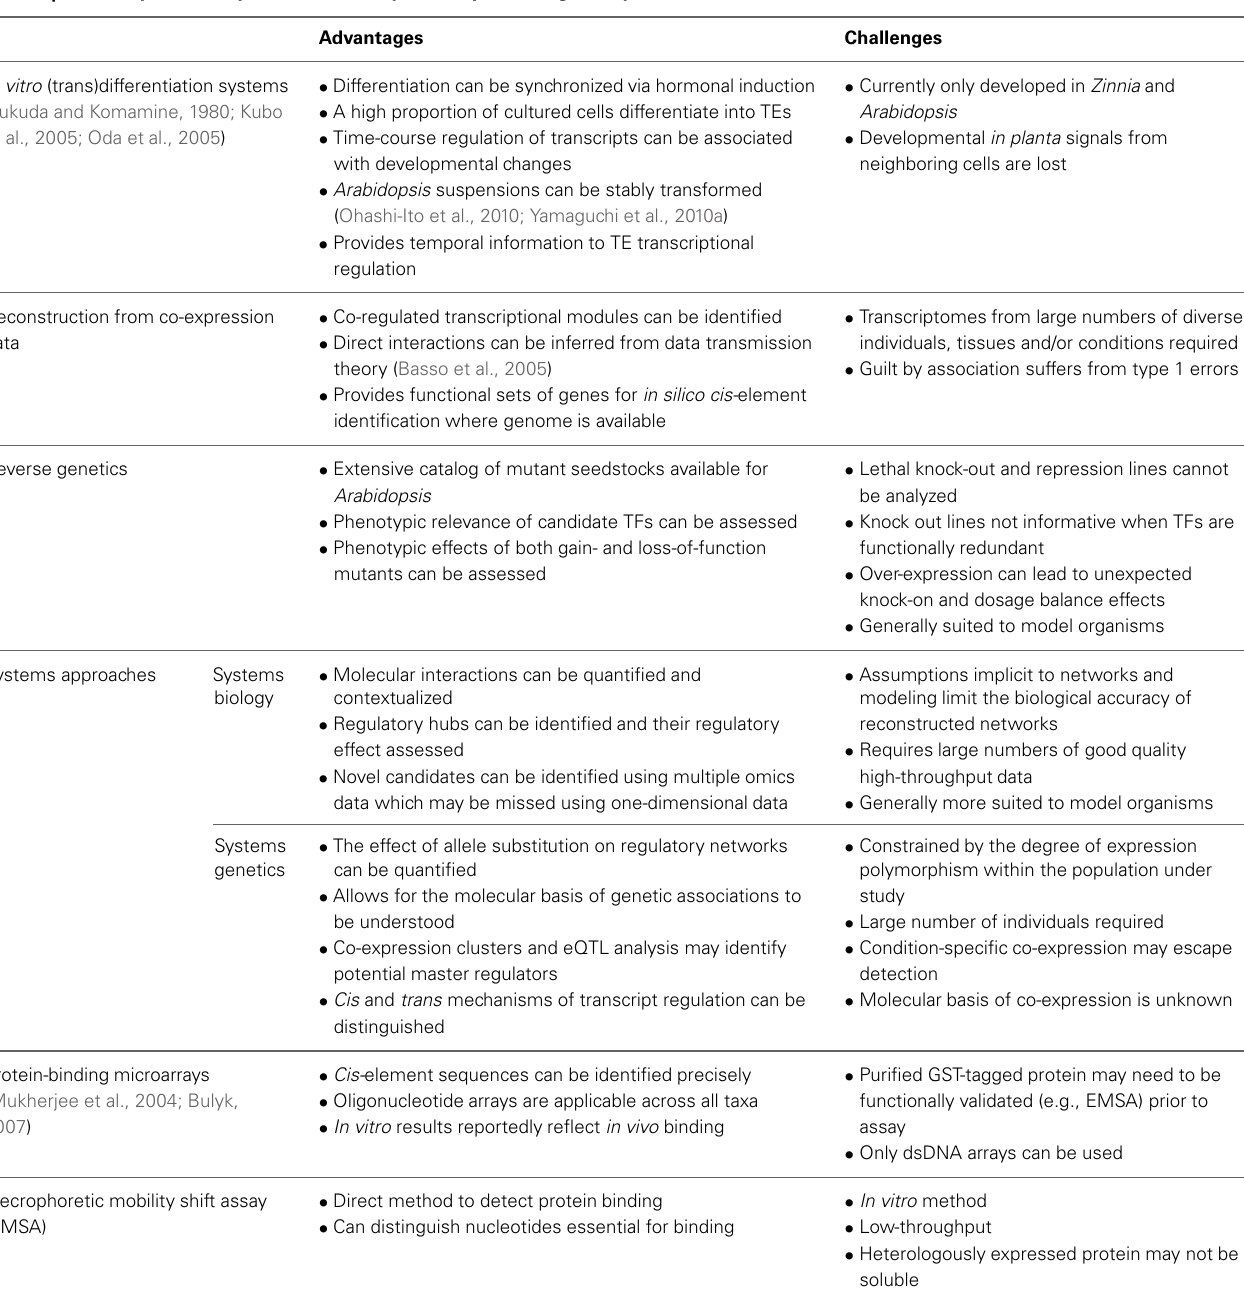
Table 2 | Summary of techniques used to study transcriptional regulatory